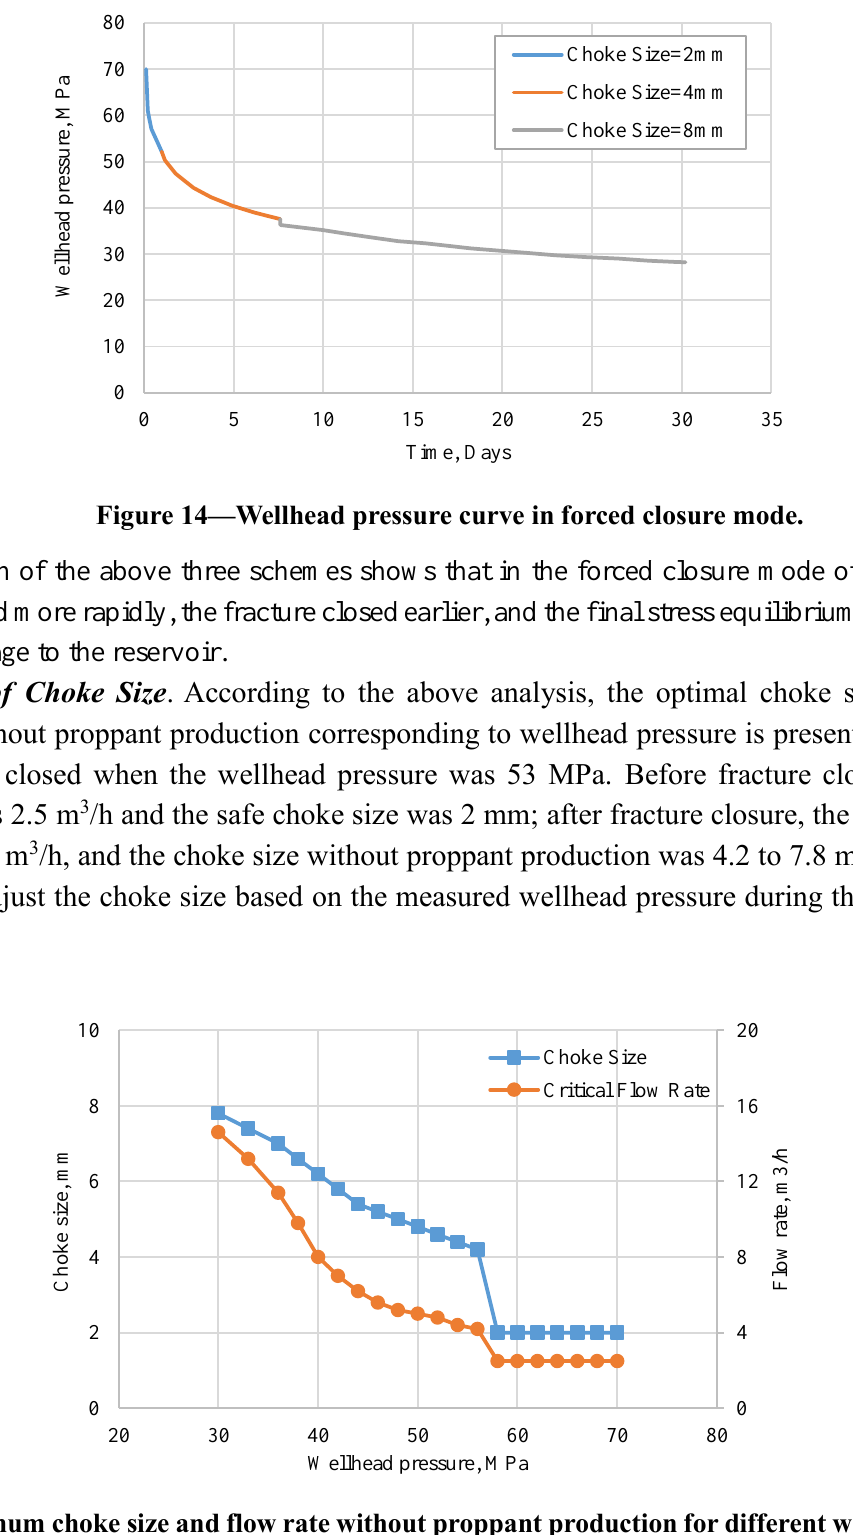
Figure 15—Maximum choke size and flow rate without proppant production for different wellhead